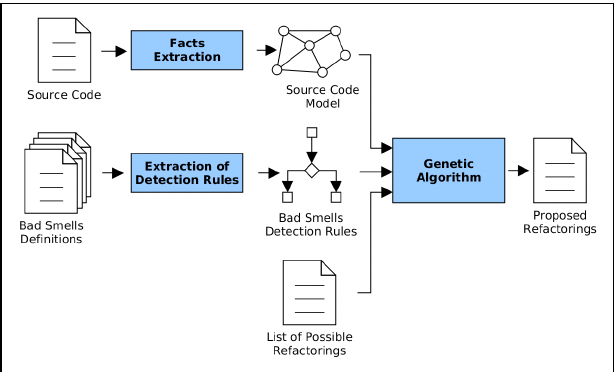
Figure 2: Overall view of our